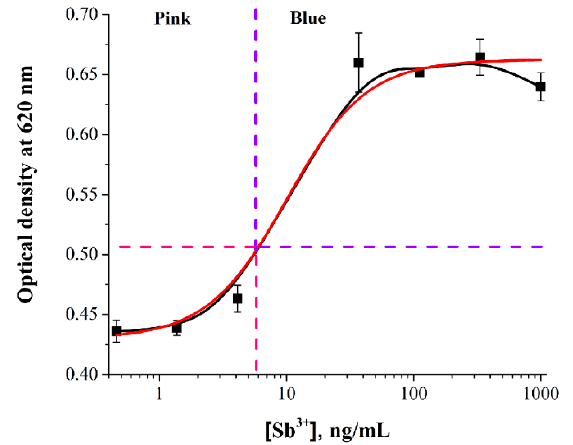
Figure 8. Dependence of optical intensity for detecting Sb 3+ in drinking water (n = 3). The points above and to the right of optical density 0.5 correspond to the blue color of the final reaction mixture, and the points below and left to this level correspond to pink (y = 0.66 + (0.43 − 0.66)/(1 + (x/10.05)^1.38), (R 2 = 0.98)). All experiments were undertaken in three replicates.